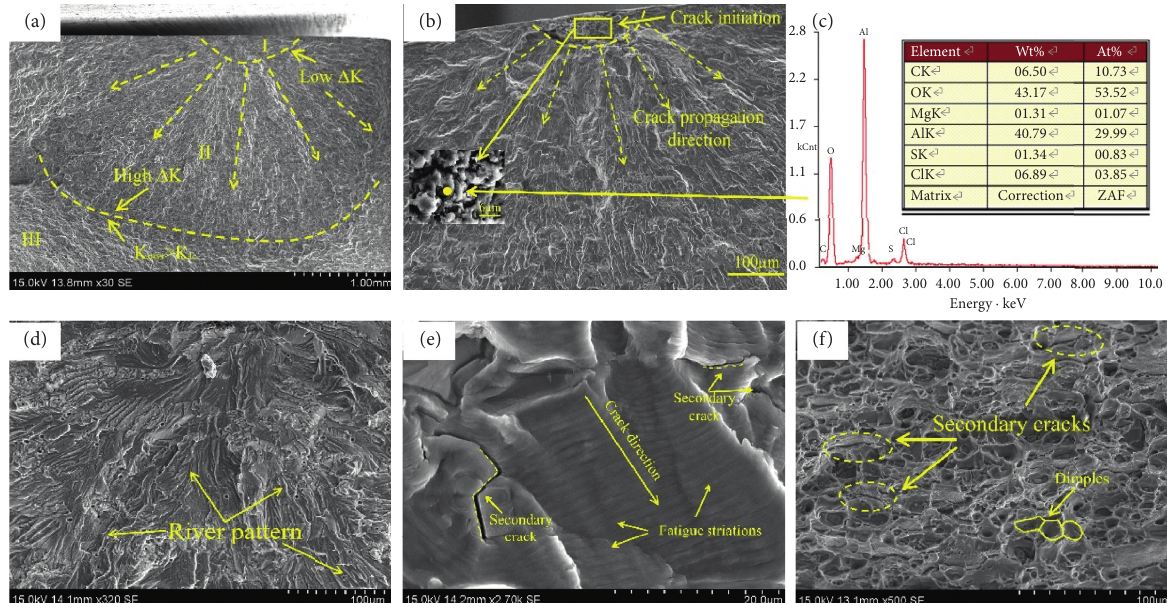
Figure 7: Fracture morphology of BM fatigue sample with stress amplitude of 121MPa. (a) Overall fracture morphology. (b) Crack source. (c) Energy spectrum analysis result of yellow point in (b). (d) Fatigue crack propagation region. (e) Fatigue striation morphology. (f) Transient fracture